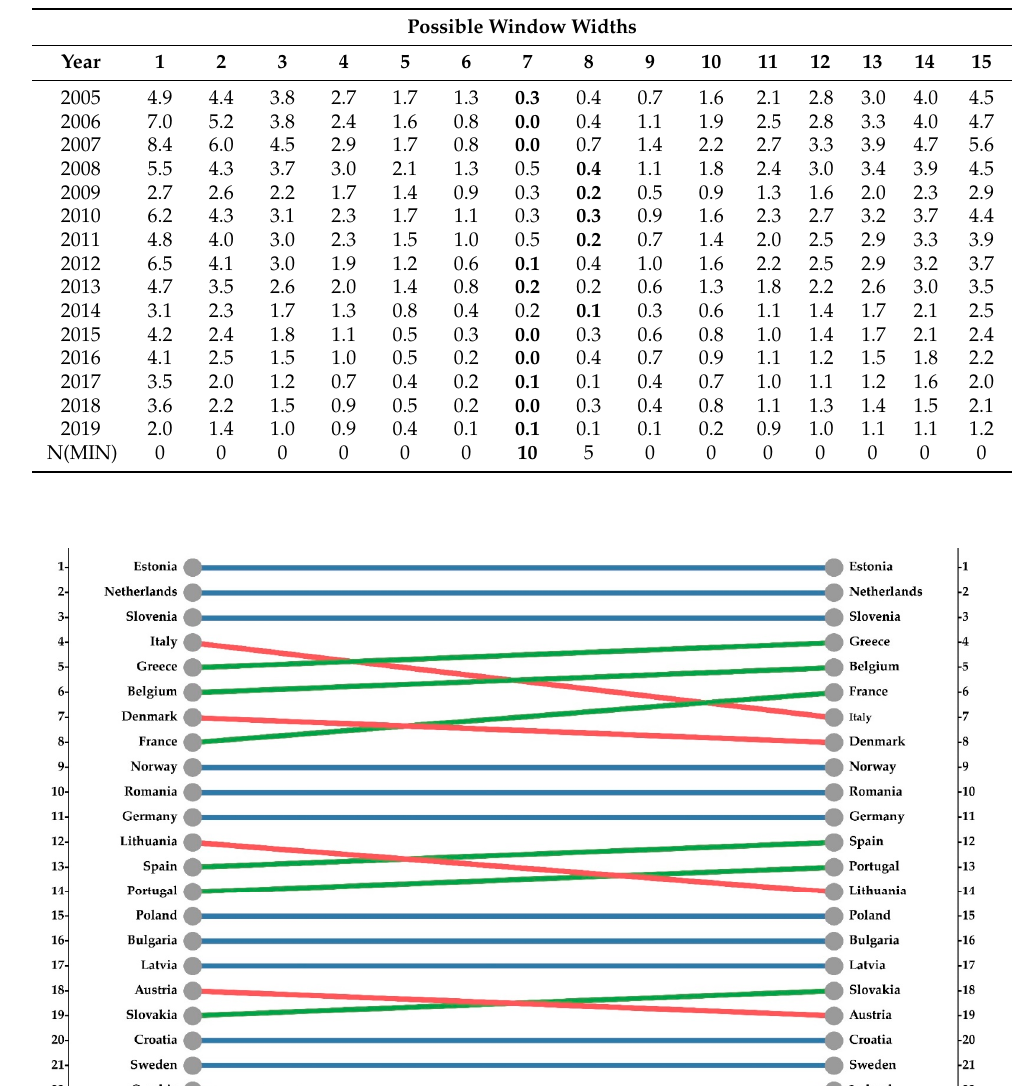
Table 5. Equation (2) results (absolute values) for all possible window lengths for the reference period 2005–2022.